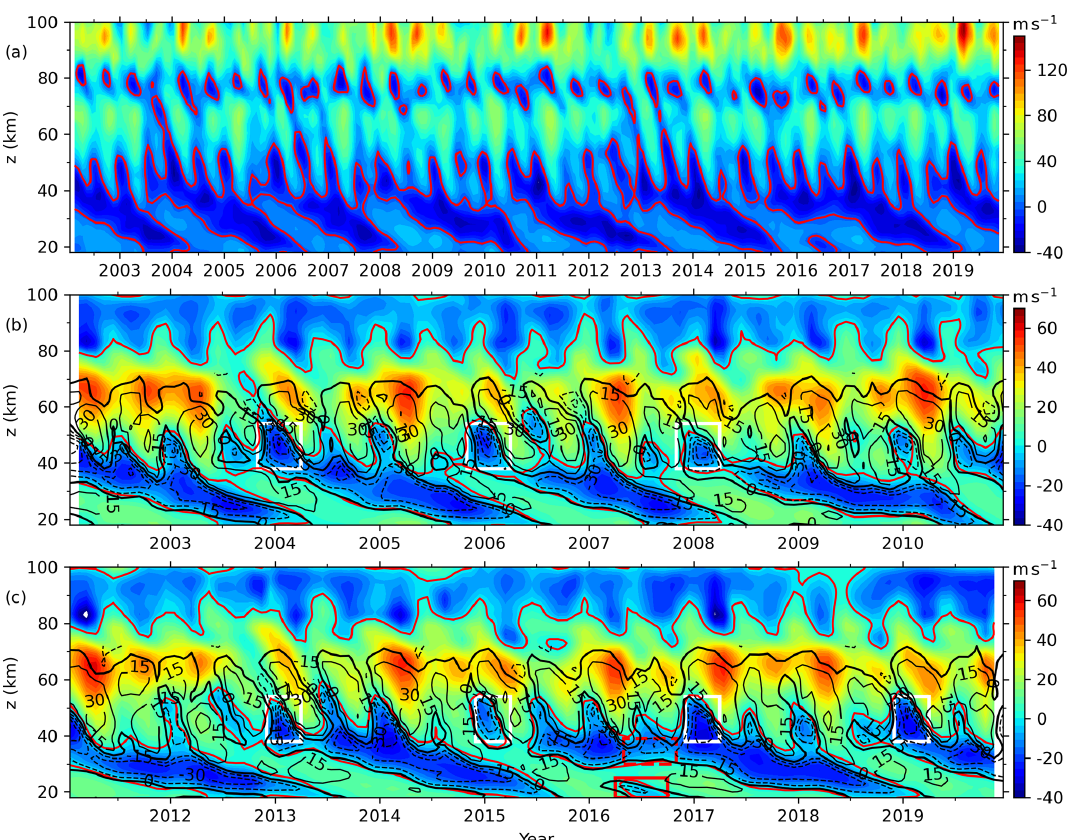
Figure 2. The BU (color filled contour, positive for eastward) calculated by Eq. (4) at the Equator at 18–100km ( a : 2002–2019) and the reconstructed BU ( b : 2002–2010; c : 2011–2019). The over-plotting contour lines show MerU (interval of 15ms − 1 ; the eastward and westward winds are represented as solid and dashed lines, respectively). The white rectangles highlight the fast westward jet during the beginning of the QBO westward phase. The red and thick black contour lines are the zero winds of BU of MerU, respectively. The solid and dashed red rectangles show the disrupted QBO in 2016. The ticks on the x axis mark the beginning of each